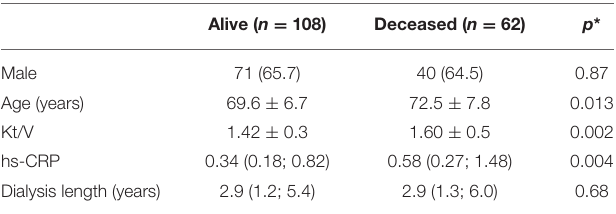
TABLE 3 | Comparison of older adult patients on hemodialysis according to the group alive and deceased ( n =